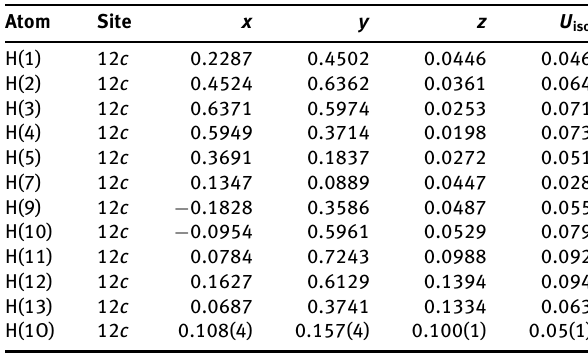
Table 2: Fractional atomic coordinates and isotropic or equivalent isotropic displacement parameters (Å 2